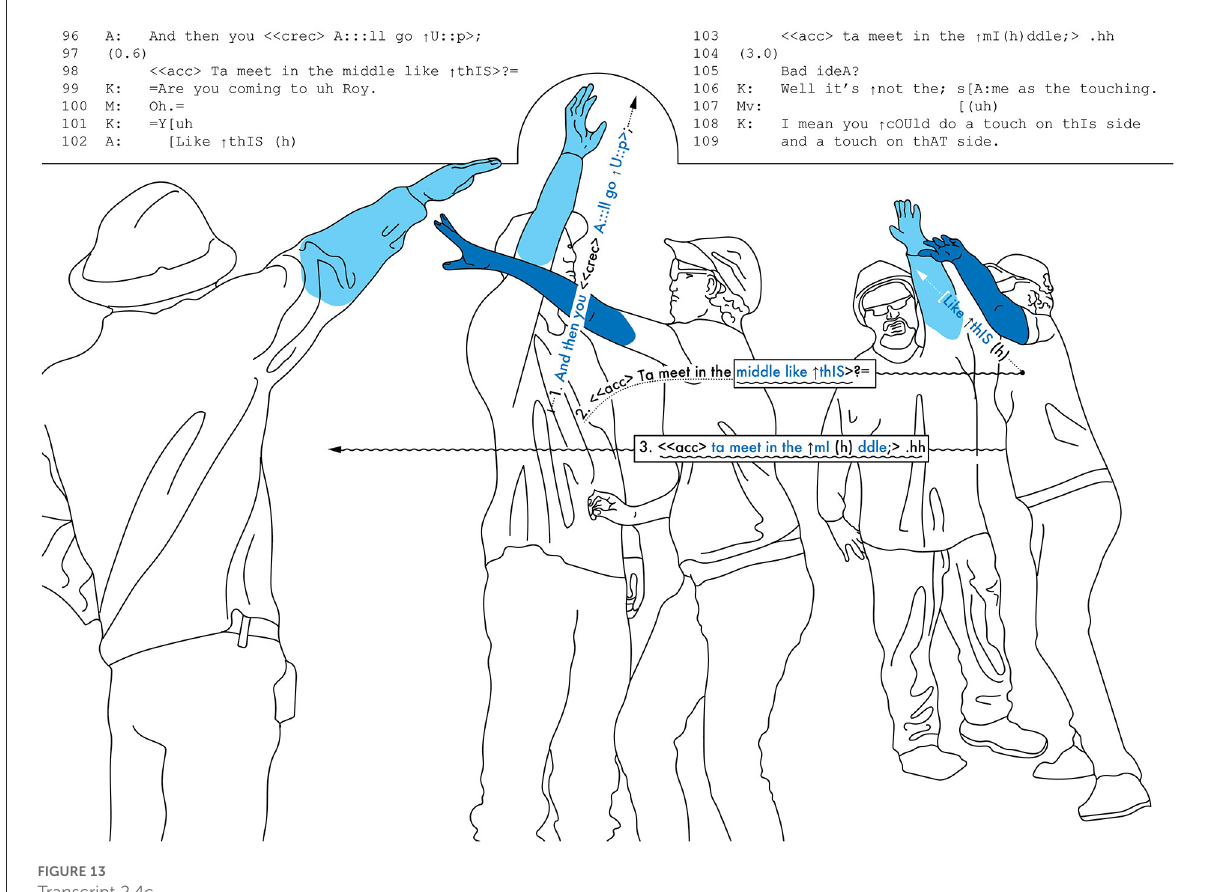
FIGURE13 Transcript